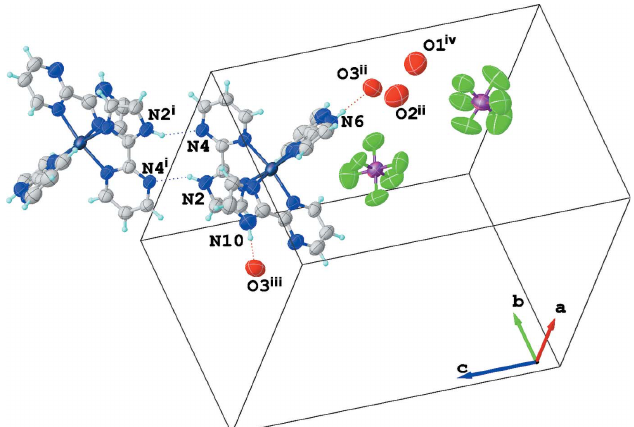
Figure 2 Outline of the unit cell with axes showing all molecular entities in the crystal. Details of the hydrogen bonds found for the [Ru( L ) 3 ] 2+ unit are also shown. Dashed lines indicate the mutual N—H (cid:2)(cid:2)(cid:2) N array between two symmetric complexes through one of the heteroaryl-imidazole ligands and two hydrogen bonds with water molecules. Symmetry codes: (i) (cid:4) x + 1, (cid:4) y + 2, (cid:4) z + 2; (ii) x + 1 , (cid:4) y + 3 , z (cid:4) 1 ; (iii) (cid:4) x + 1, (cid:4) y + 1, 2 2 2 (cid:4) z + 2; (iv) (cid:4) x + 1, (cid:4) y + 2, (cid:4) z + 1. Water H atoms were not found, see text for details. Atoms of the PF 6 (cid:4) anion in the upper right corner have symmetry code